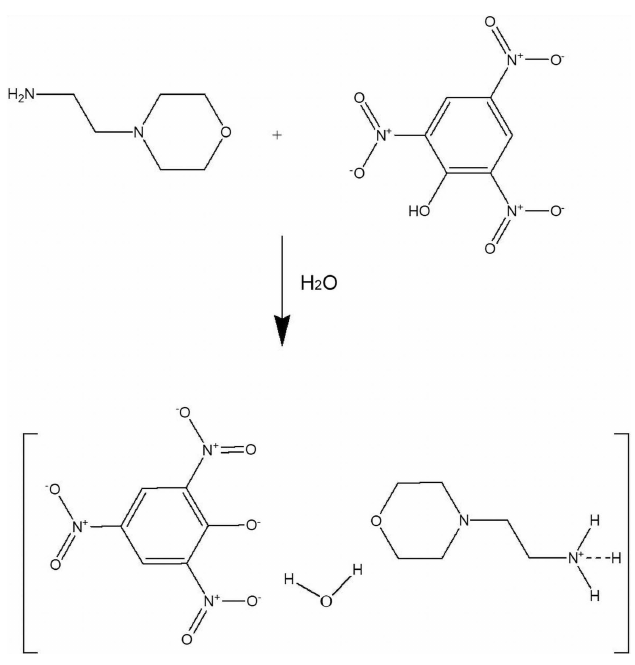
Figure 9 Reaction scheme for the title compound.